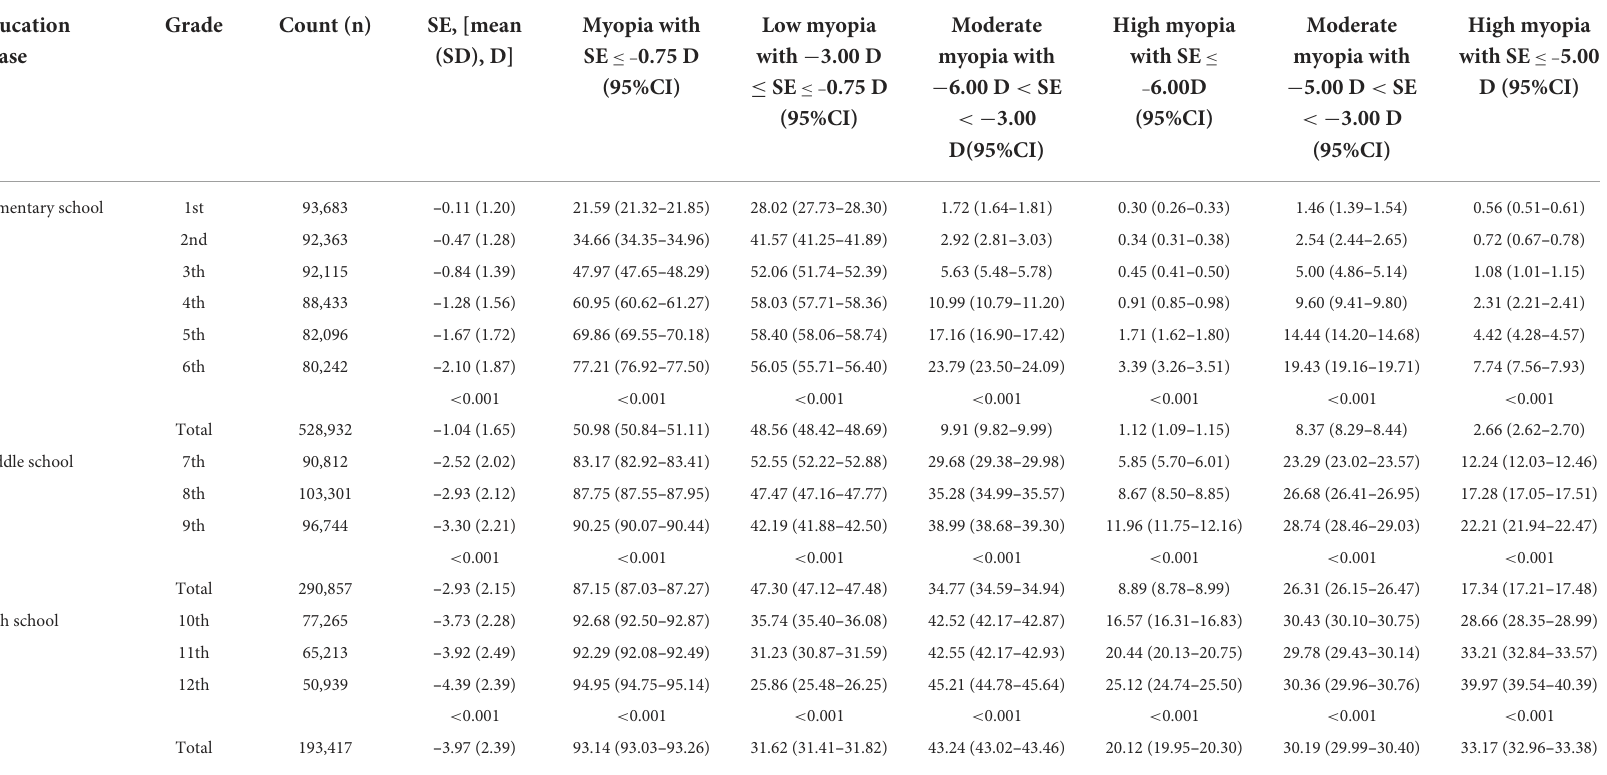
TABLE 3 Distribution of different grades of myopia stratify by school levels